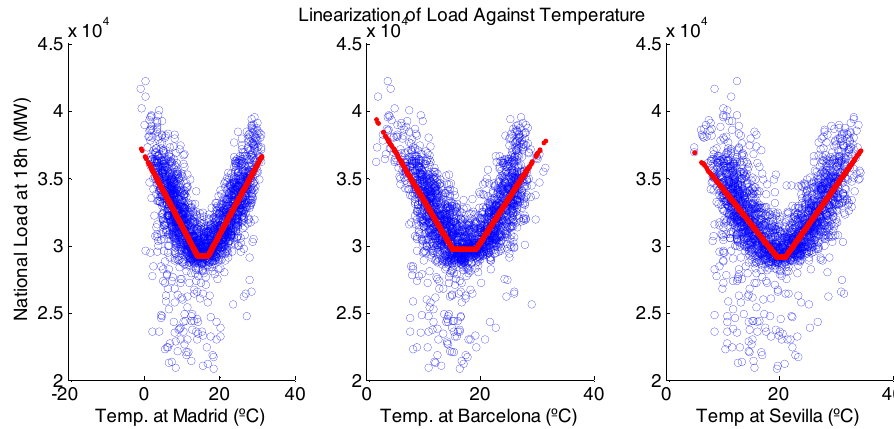
Figure 6. Scatter plot of national load and its linearization against temperature at Madrid, Barcelona and Sevilla.